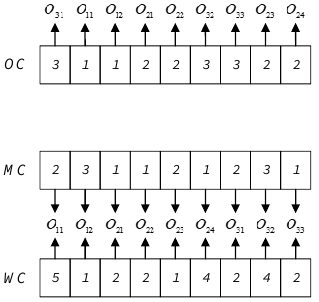
Figure 1. Three-segment encoding scheme.